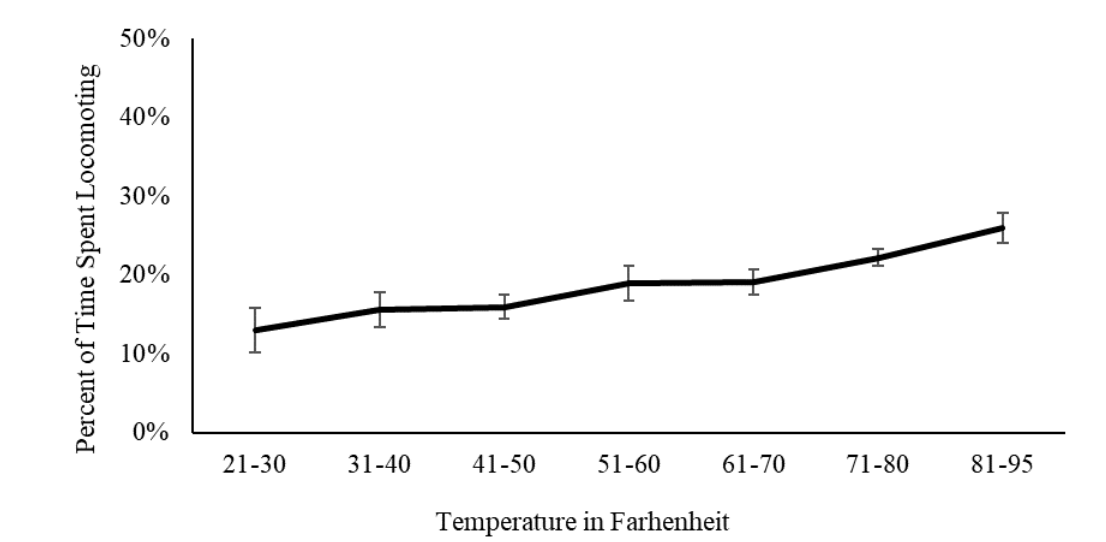
Mean Percentage of Time Spent Locomoting by